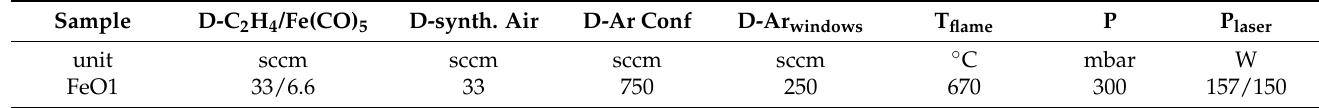
Table 1. Experimental